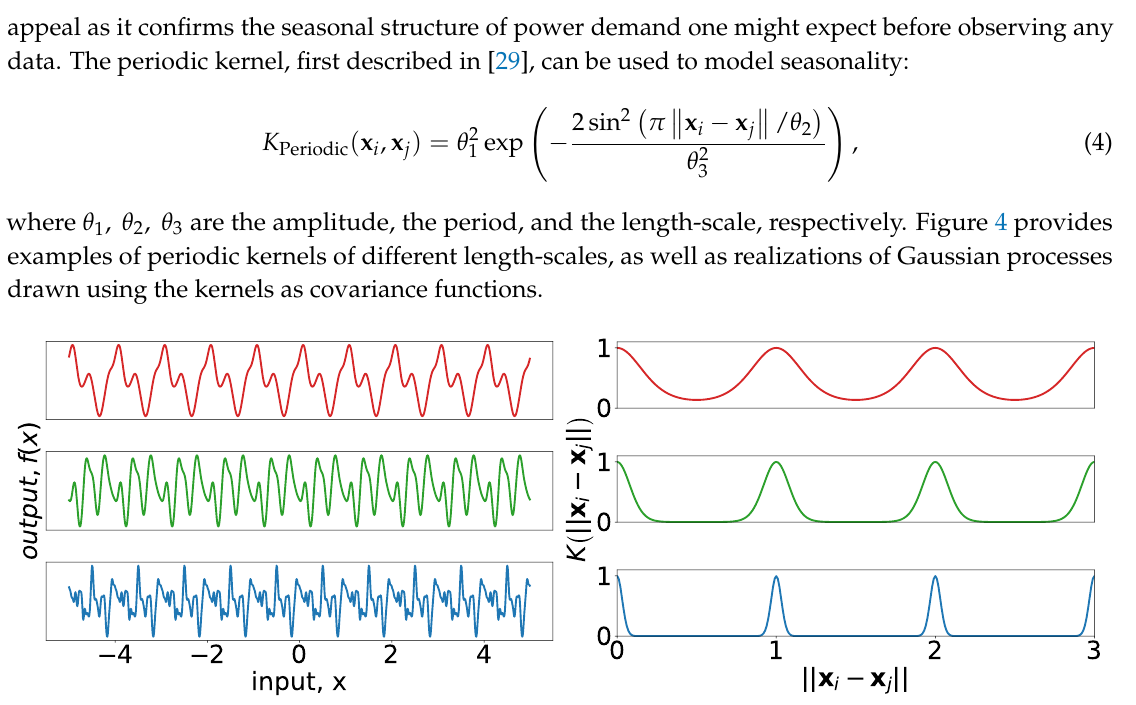
Figure 4. ( left ) Random simulations from Gaussian processes with covariances defined by three different periodic kernels. In all cases, the amplitude is 1 and the period is 1. The length-scales are 2, 1, 0.5 for top, middle, and bottom, respectively. ( right ) Covariance kernels corresponding to the cases on the left.